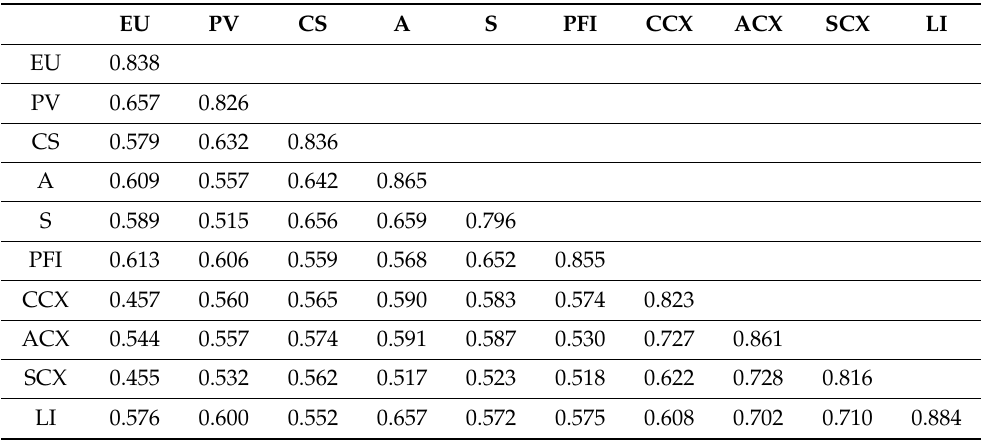
Table 4. Discriminant validity.